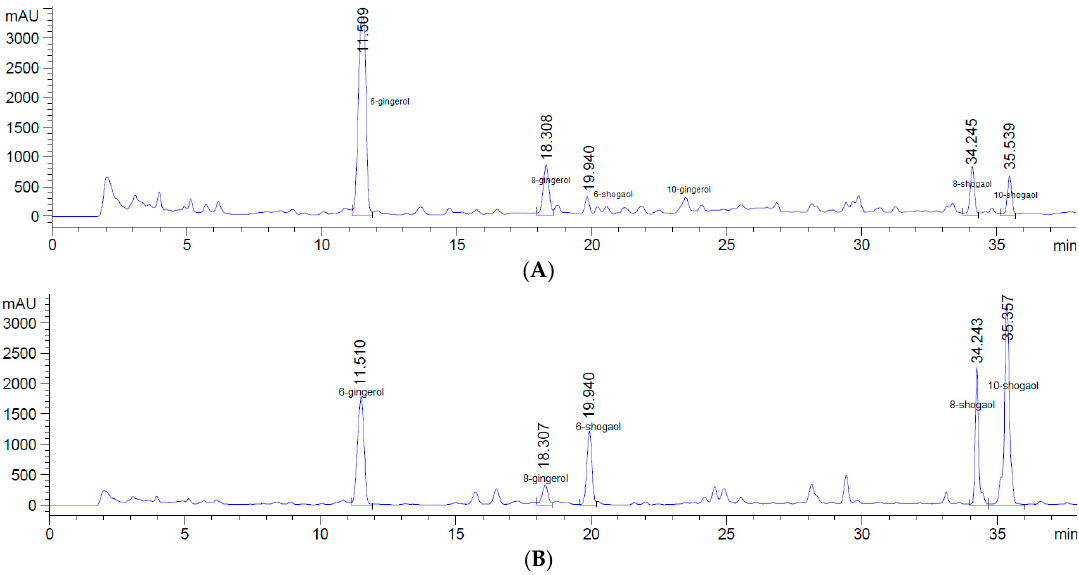
Figure 1. HPLC full chromatogram of ginger extract, dried with OSD ( A ) and HAD ( B ) at 150 °C.